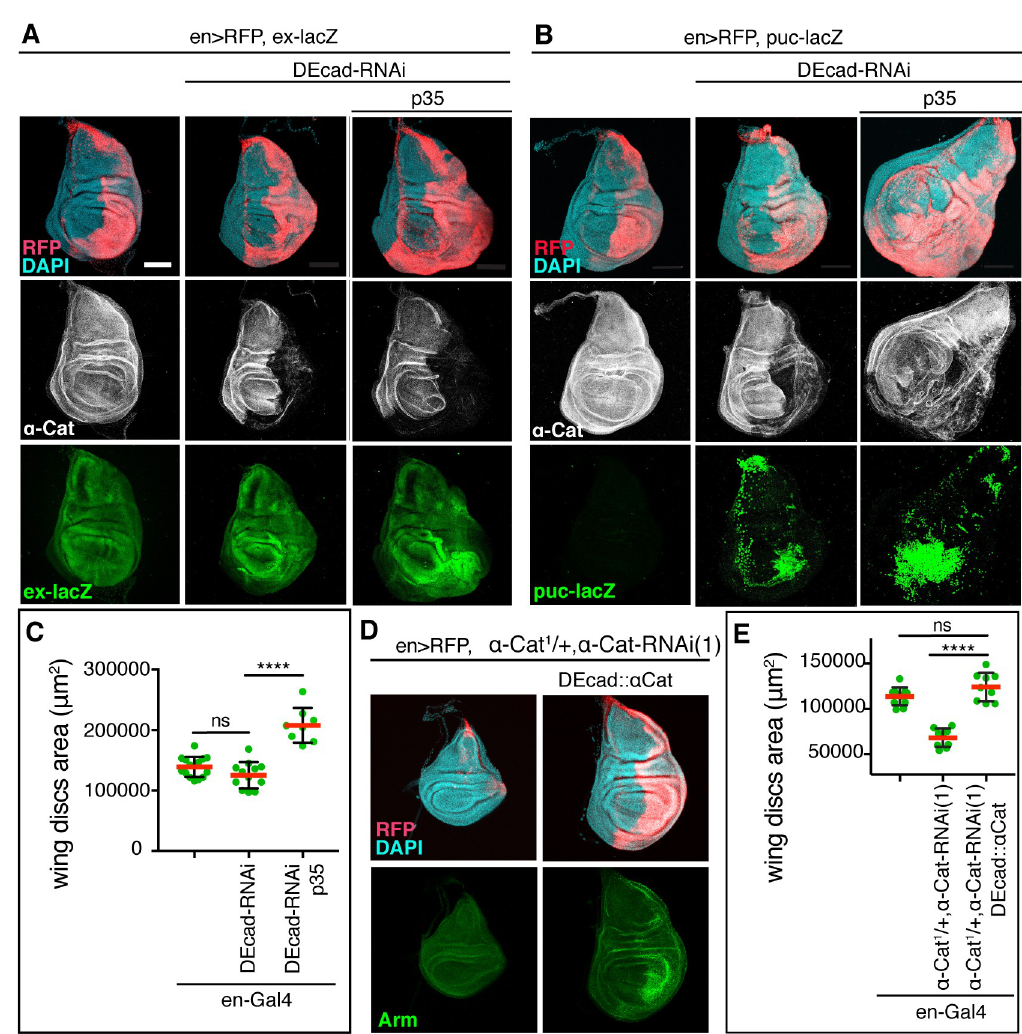
Fig 3. α -Cat regulates tissue growth as a DEcad binding partner. (A) KD of DEcad enhances activation of the Yki transcriptional reporter ex-LacZ . KD of DEcad in conjunction with expression of p35 causes tissue overgrowth. Scale bars, 100 μ m. (B) KD of DEcad with or without co-expression of p35 causes activation of the JNK transcriptional reporter puc-LacZ . KD of DEcad in conjunction with expression of p35 causes tissue overgrowth. Scale bars, 100 μ m. (C) Quantification of late 3 rd larval instar wing disc area in DEcad KD flies. Two-tailed, unpaired t-test; ns (P > 0.05), ���� (P � 0.0001). (D, E) Sample discs (D) and quantification of disc area (E) of late 3 rd larval instar wing discs of the indicated genotypes. Expression of DEcad:: α Cat in en > α -Cat-RNAi(1) , α -Cat/+ restored normal wing disc size as seen in en-Gal4 controls. Two-tailed, unpaired t-test; ns (P > 0.05), ���� (P � 0.0001).